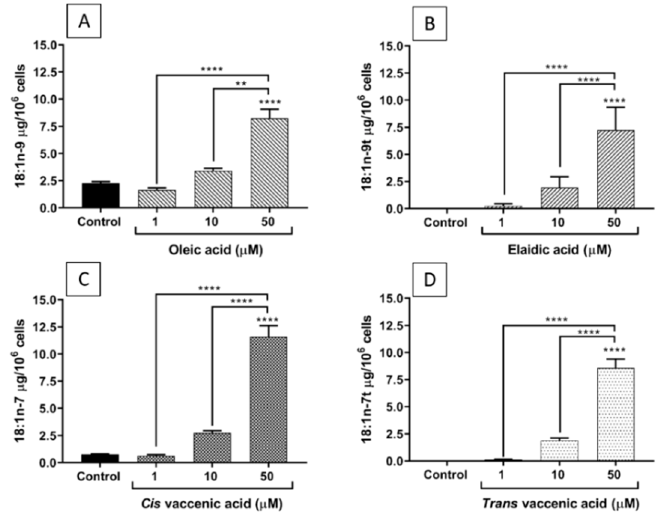
Figure 2. Incorporation of FAs into EA.hy926 cells incubated for 48 h with DMEM containing 0.1% of ethanol (Control) or different concentrations (1, 10, and 50 μ M) of oleic acid ( A ), elaidic acid ( B ), cis vaccenic acid ( C ), or trans vaccenic acid ( D ). Bars are mean ± SEM of 6 to 9 samples performed in 3 experiments. Data were analysed using one-way ANOVA with Tukey’s post hoc test. ** p < 0.01; **** p < 0.0001 between groups indicated by joined lines or vs. Control when there is no joined line.